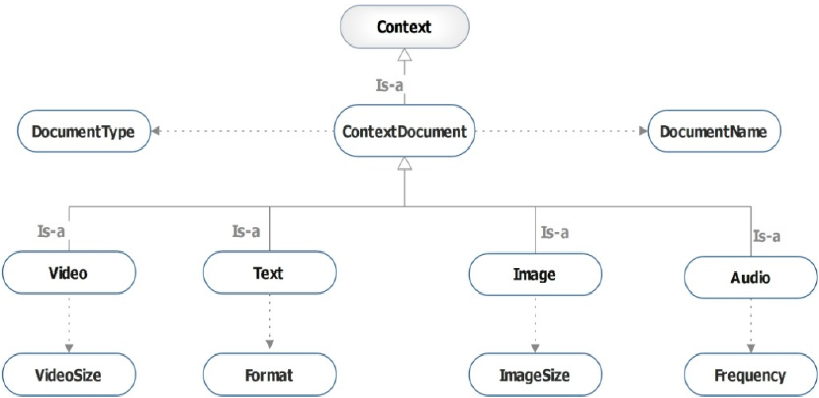
Figure 9. Document context sub ‐ ontology.